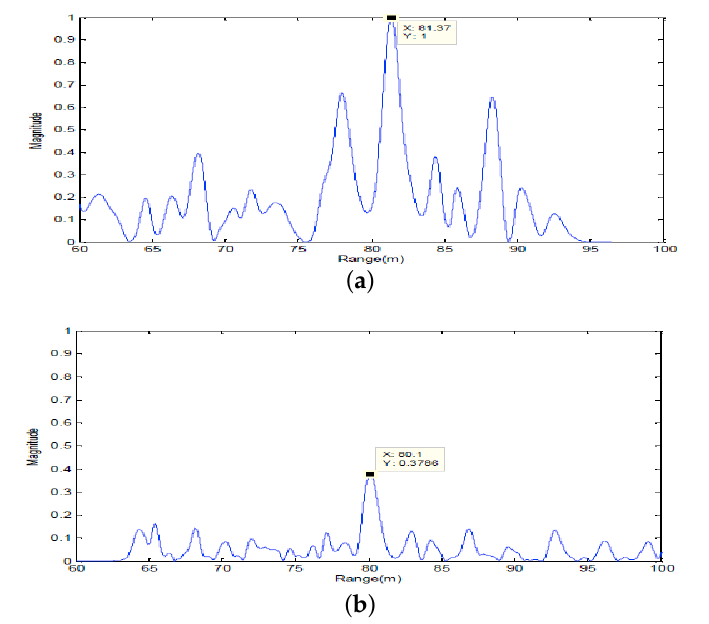
Figure 20. The outputs of the replica correlation integration processer with LFM signals: ( a ) the distributed TR-MIMO sonar system; ( b ) the distributed phased-MIMO sonar system. Note that the outputs are normalized by the maximum value of the outputs of the distributed TR-MIMO sonar